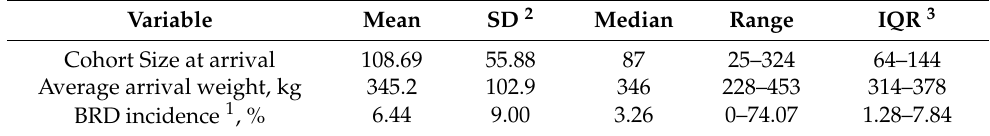
Table 2. Distribution of variables used for analysis from 10 United States feedlots from